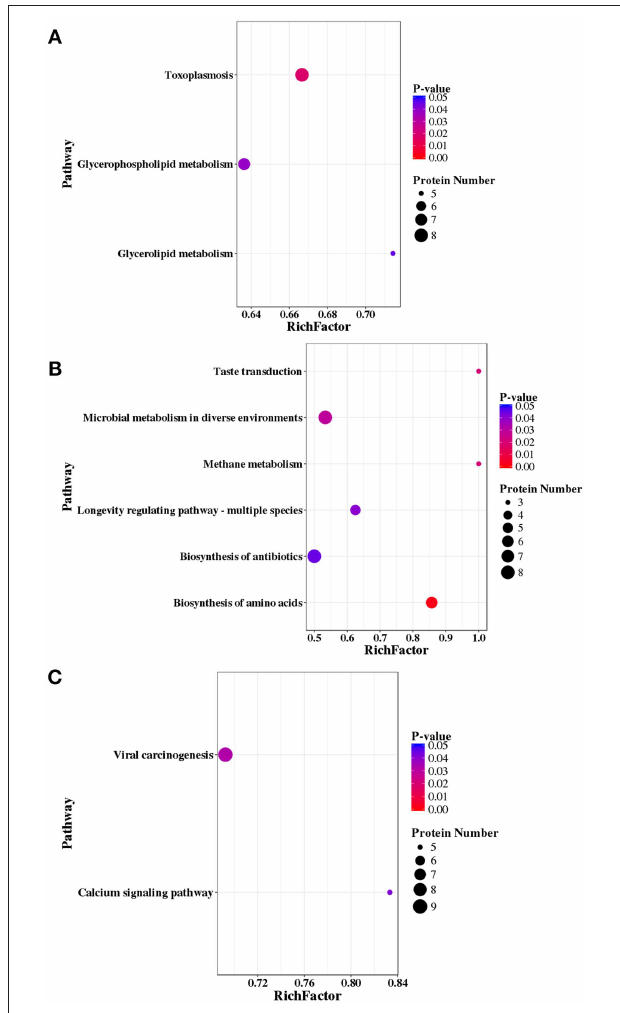
FIGURE 9 | KEGG pathway analysis of differentially expressed phosphoproteins (DEPs) in RH strain when comparing RH/PRU strains, in PRU strain when comparing PRU/PYS strains, and in PYS strain when comparing PYS/RH strains. The vertical axis shows the significantly enriched KEGG pathways and the horizontal axis represents the rich factors corresponding to the pathways. Rich factor refers to the ratio of the number of DEPs to the number of all phosphoproteins in the pathway. Higher Rich factors indicate greater degrees of enrichment. The size and color of the node represent number of phosphoproteins and p -value of pathways. The scatter plots represent KEGG pathways of the DEPs in (A) RH strain when comparing RH/PRU strains, (B) in PRU strain when comparing PRU/PYS strains, and (C) in PYS strain when comparing PYS/RH strains,